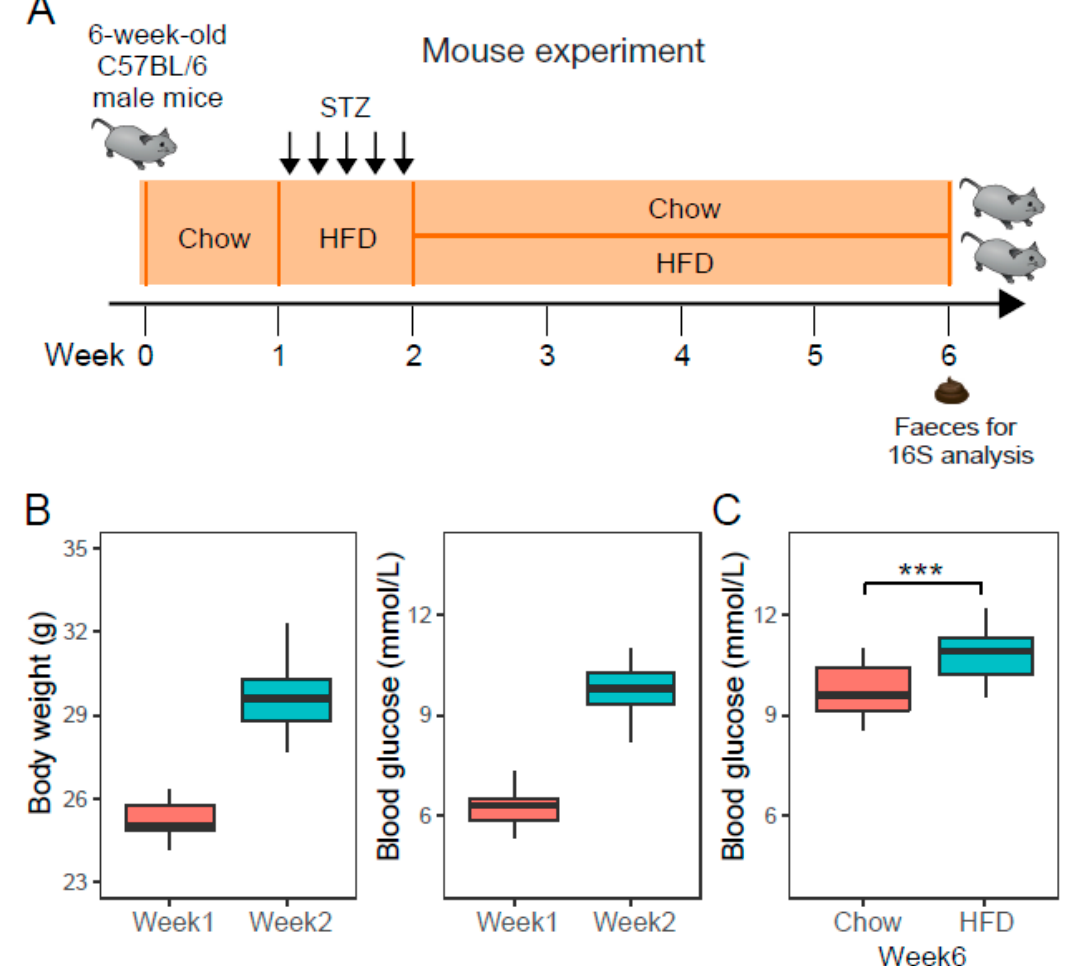
Figure 1. The experimental design and type 2 diabetes (T2D) mouse model. ( A ) Mouse experiment, 6-week-old C57BL/6 male mice ( n = 50) were fed on a standard chow diet for one week, then injected with multiple low doses of streptozotocin (STZ) and fed on a high-fat diet (HFD) to obtain T2D mice. T2D mice received chow or HFD for four consecutive weeks. ( B ) Boxplot of body weight and fasting blood glucose in mice ( n = 50) at the time point of week 1 and week 2. ( C ) Boxplot of fasting blood glucose in chow-fed T2D mice (Chow, n = 23) and HFD-fed T2D mice (HFD, n = 23) at week 6. *** denotes p < 0.001.